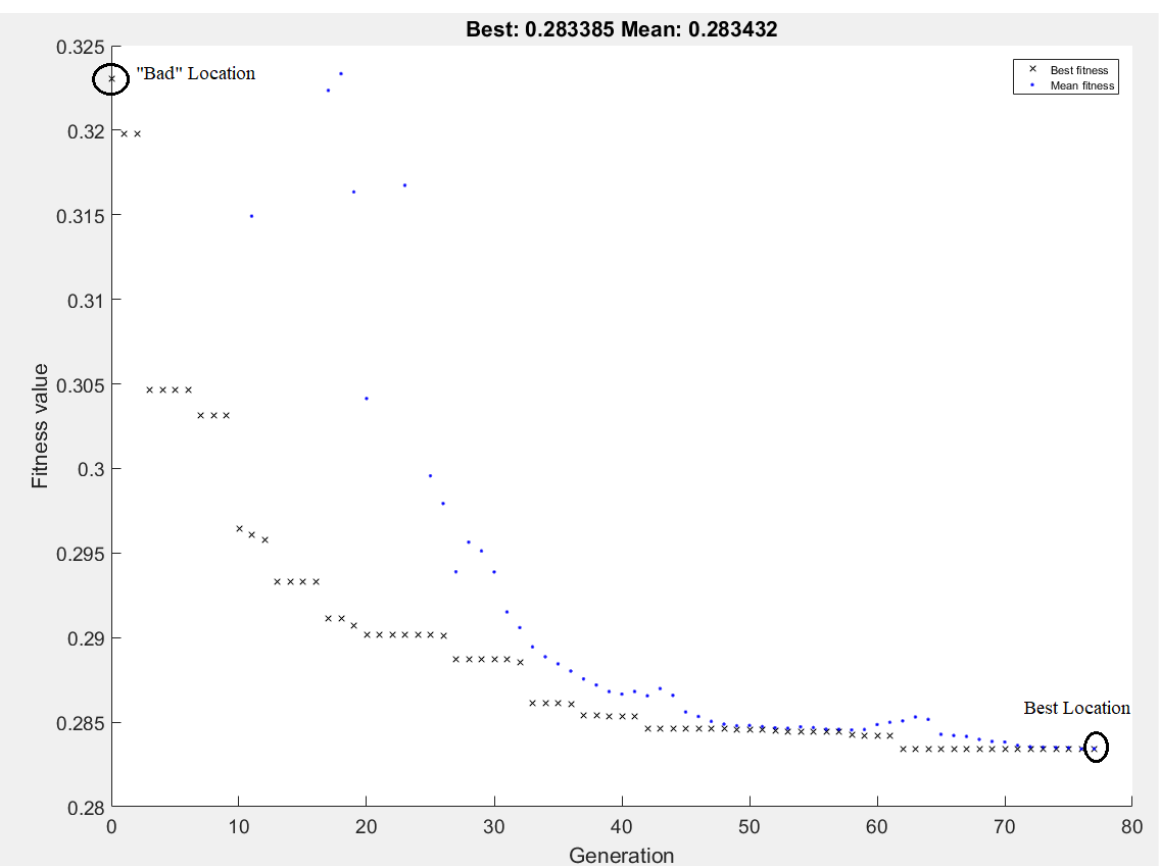
Figure 5. The optimization process, showing the improvement of fitness function step by step and the steps where the “bad” and best task locations for the path ‐ following task were derived.